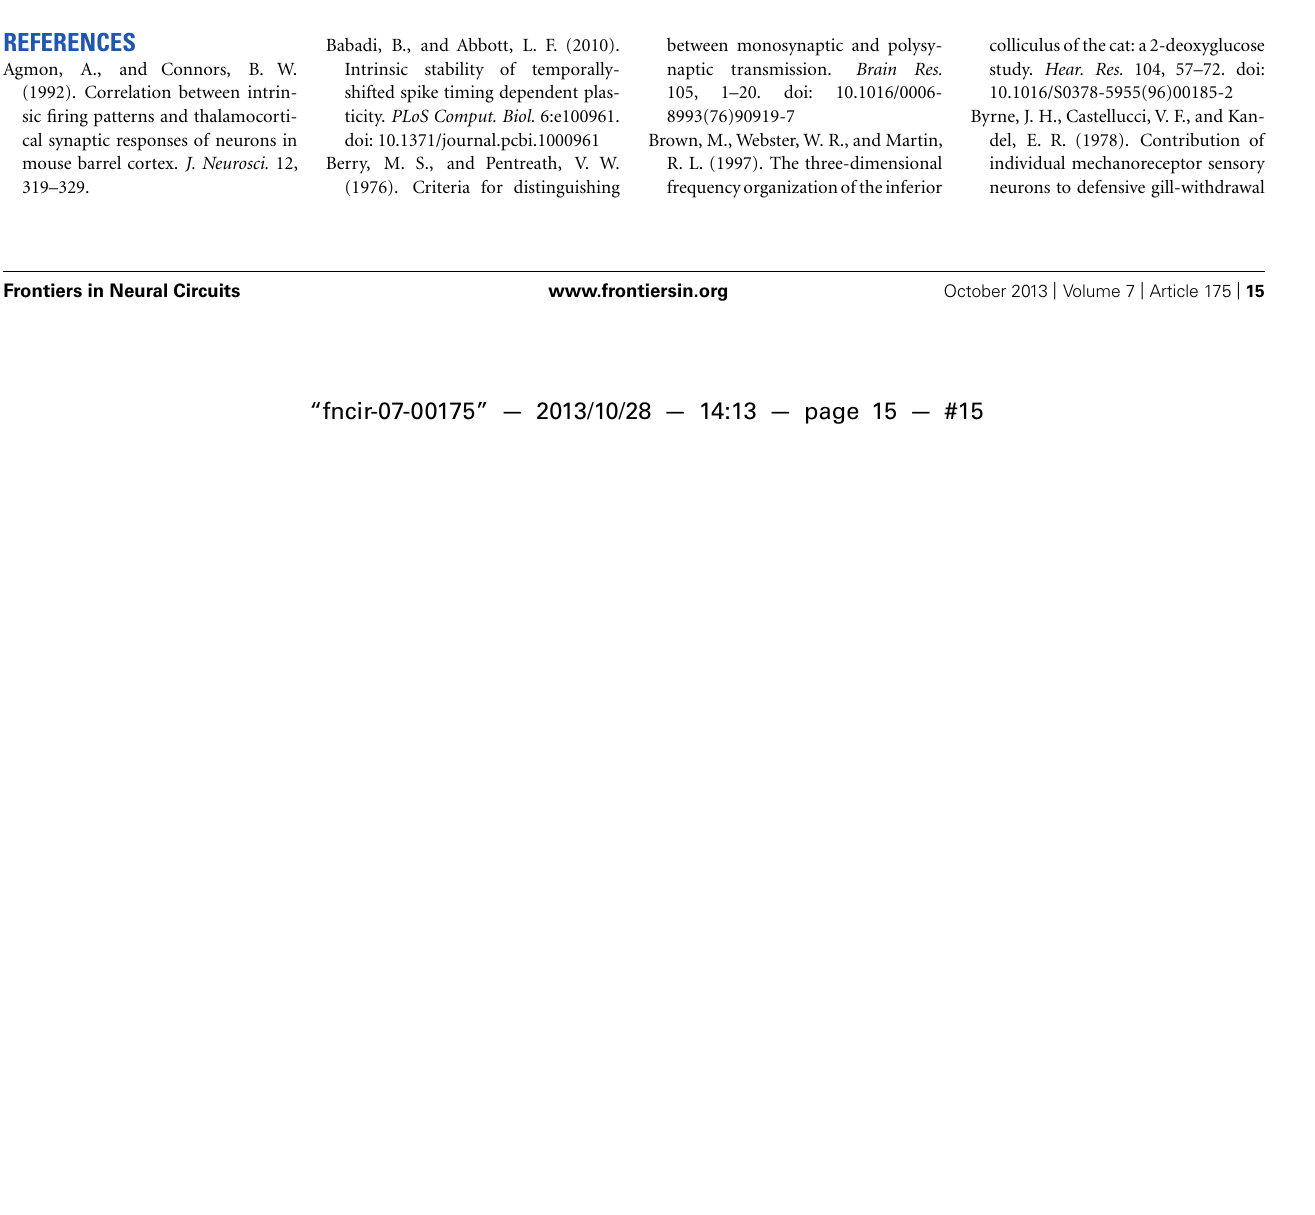
post-inhibitory rebound firing. HiDi did not abolish rebound firing but blocked activity during the tone. In strychnine/HiDi, firing during the tone returned and was strong, however, the threshold for firing was higher than in the control, suggesting that the glycine input was a high-threshold inhibitory input. Right: RIFs plotted early, 10–20 ms (from the first spike latency) and during the whole response to the tone (10–150 ms). At early times, the control RIF has two non-monotonic components that activate at low and high-intensities. HiDi blocks only the high-intensity component. Strychnine/HiDi, increased firing during the high-intensity component only.Thus this neuron receives two monosynaptic components: an excitatory input at low intensities and an inhibitory glycinergic input at high